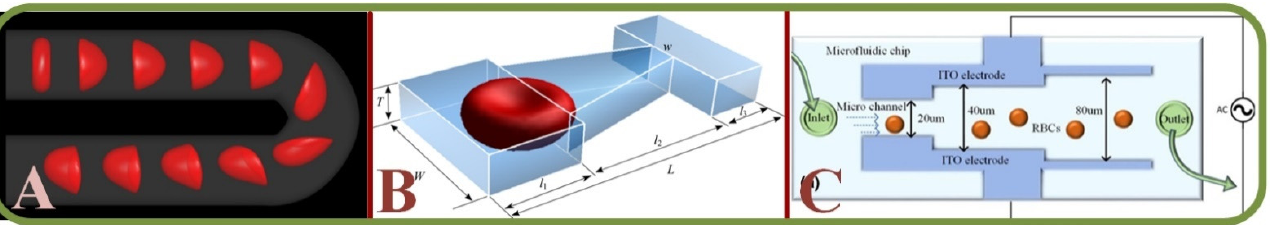
Figure 10. Deformation of single erythrocytes in microchannels. ( A ) Single RBC deformation sequences in a curved micro-vessel [152]; ( B ) A microfluidic chip for studying the critical pressure to drive a RBC through a contracting microfluidic channel [160]; ( C ) The microfluidic system to measure the RBC deformability with parallel electrodes in a microfluidic manipulation system [159].